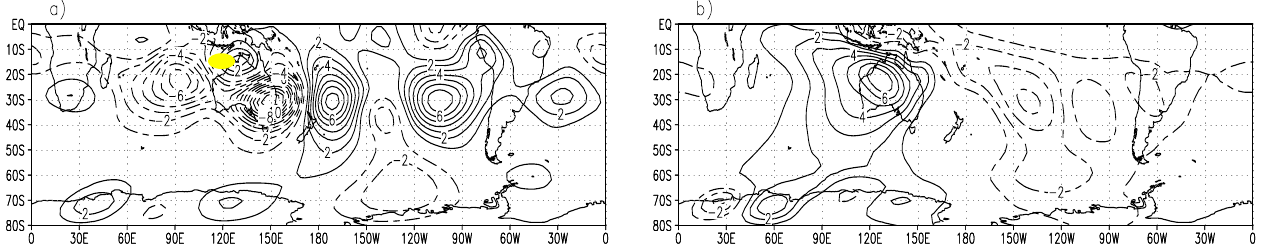
Figure 5 : Stream function anomalies (1x10 -6 m 2 s -1 ) at 250 hPa (a) and 850 hPa (b), on day 10 of integration, corresponding to the mean winter basic state experiment with the forcing at 120ºE-15ºS (see gray dot in the figure)